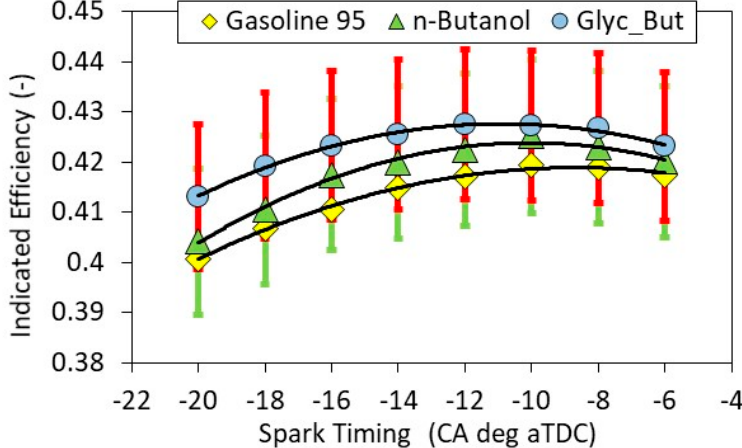
Figure 7. Indicated efficiency vs. spark timing for the tested fuels. As can be concluded from Figure 7, this efficiency for n-butanol and Glyc_But tests does not deteriorate, and it can even be said that it improves slightly in comparison to the gasoline test. However, one may find that this improvement is questionable because it is within the uncertainty for the indicated efficiency. However, this efficiency improvement can be reasonably explained. During tests, exhaust gas temperature was measured. The exhaust temperature sensor was installed in the tailpipe, approximately 0.5 m away from the engine exhaust valve. Hence, this temperature cannot be considered as the post-flame temperature due to a cooling effect in the tailpipe, but can provide a valuable conclusion. As depicted in Figure 8, the exhaust temperature is the lowest for the engine fueled with the Glyc_But fuel. The decrease is approximately 26 °C. In the Kelvin scale, this temperature drop is approximately 3.4%. Thus, the heat loss in the exhaust gases can decrease in the same ratio, which affects increases in both IMEP and indicated efficiency.